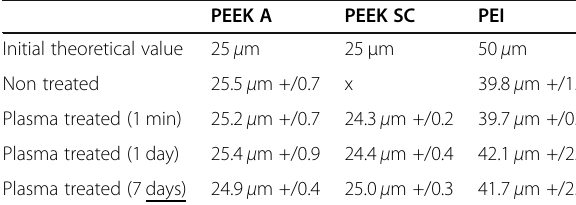
Table 4 Average visible interlayer thickness after co-curing PEEK